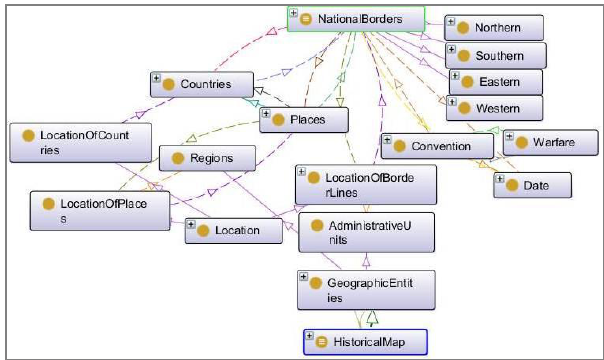
Figure 5. Excerpt of the ontology for the class NationalBorder .